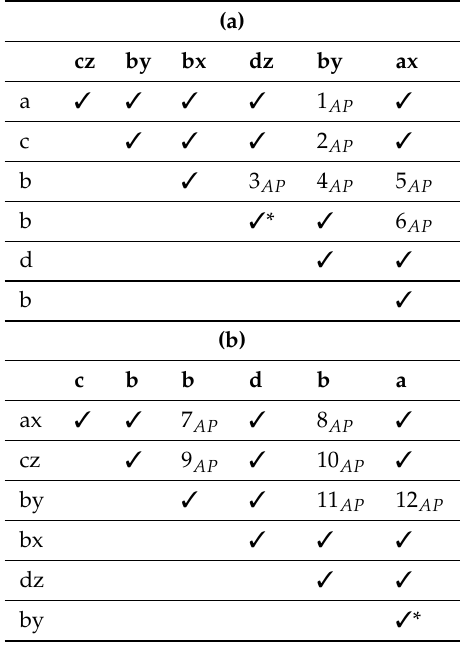
Table 16. MR-I results for alternatePrecedence constraints: ( a ) activation; and ( b )